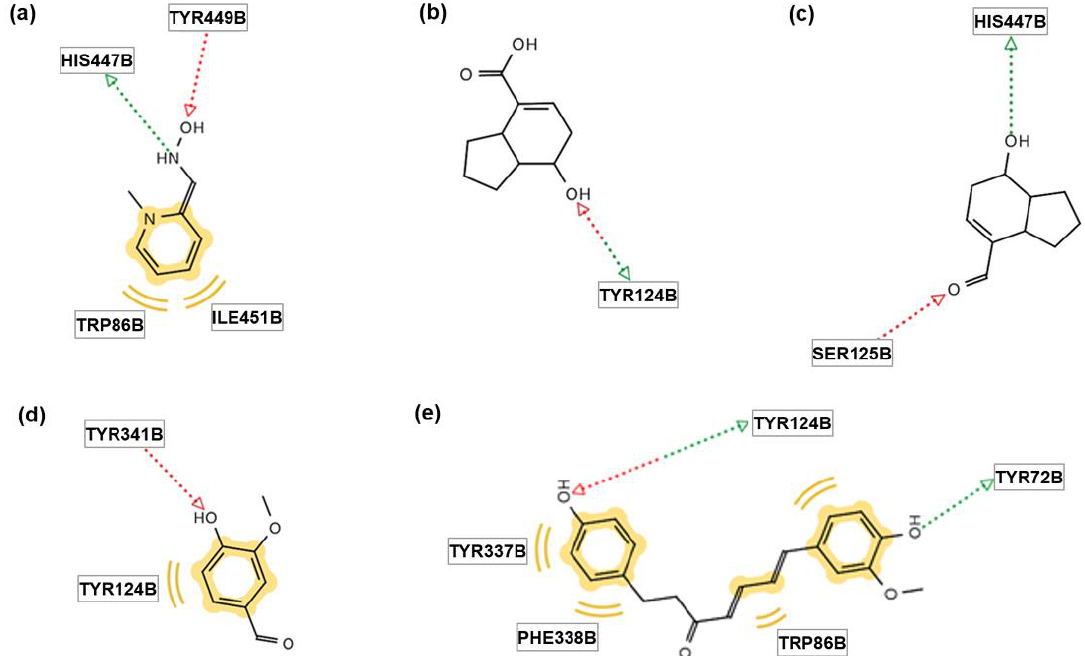
Figure 3. The pharmacophores of the tested compounds indicate the interactions between the receptor (AChE) and ligands ( 1 – 4 and FP1). The green and red arrows indicate the hydrogen bond donor and acceptor, respectively. The yellow color indicates a hydrophobic interaction or van der Waals